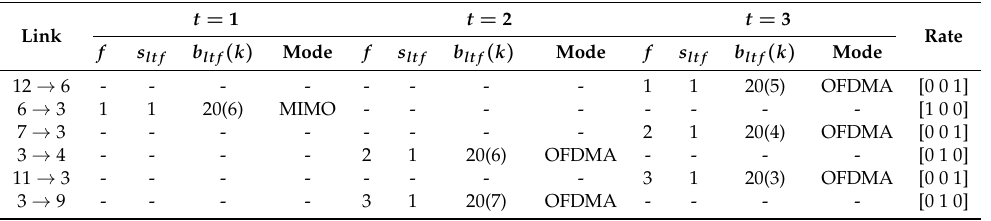
Table 8. Resource Allocation Result for the Max–Min Fair